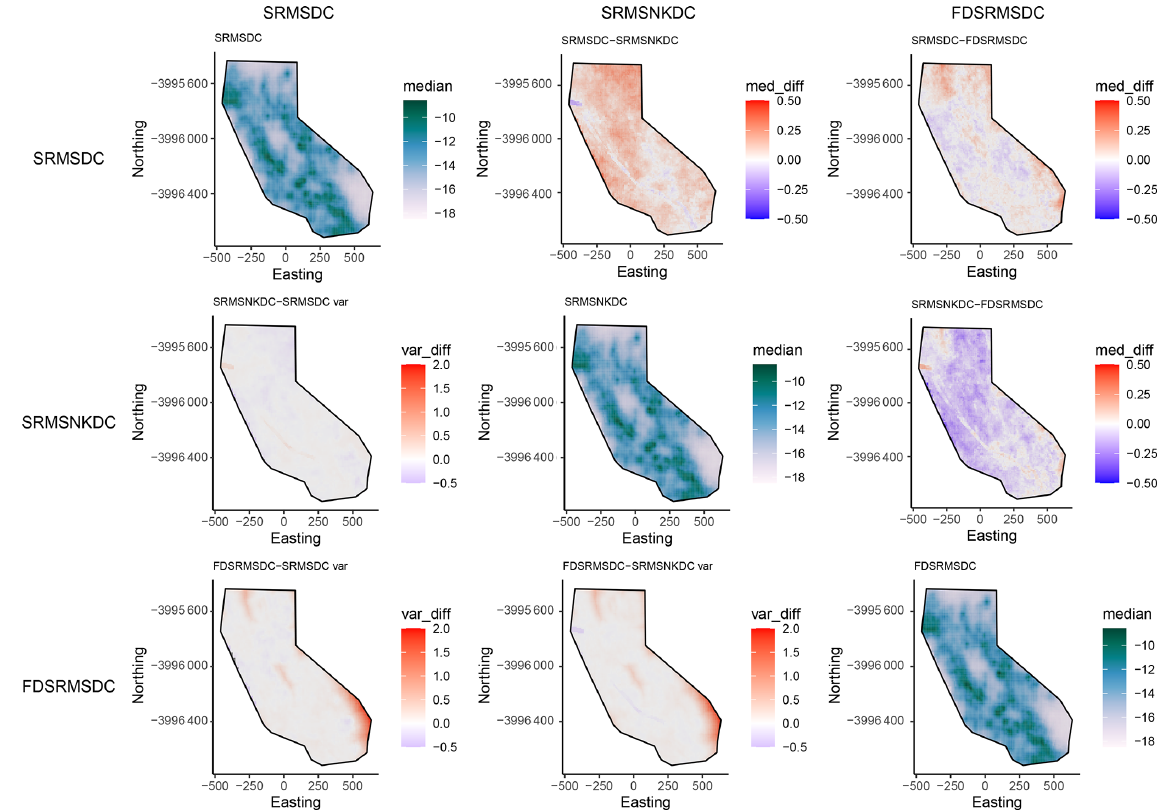
Figure 4. Pairwise comparison of models for declustered catalogue models. The top-right side of the plot shows differences in log median intensity and the lower left section shows the differences in model variances between the different models. The median log intensities for each model are shown on the diagonal. Models include combinations of smoothed past seismicity (MS), strain rate (SR), fault distance (FD) and fault slip rates